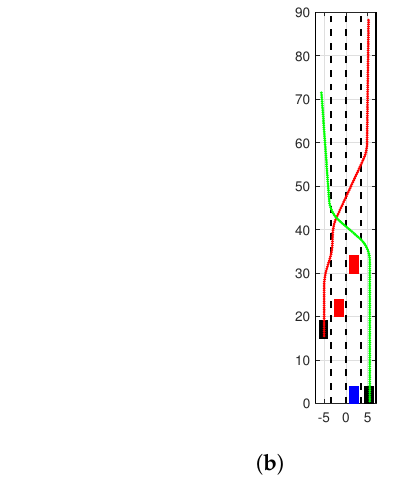
Figure 11. The figures show two simulated traffic scenarios, where a single ( a ) and multiple ( b ) vehicles are occluded for some time by other participants. The ego vehicle is marked with a blue rectangle. Observed vehicles are shown in black while occluding vehicles are red. Colored lines indicate trajectories of moving vehicles. scene1: Object is hidden between 35-64 s scene2: X1 is hidden between 30–43 s and 68-80 s. X2 is hidden between 78–83 Ego vehicle: blue Obstacle: red Observed vehicles filled black Solid line: trajectories.